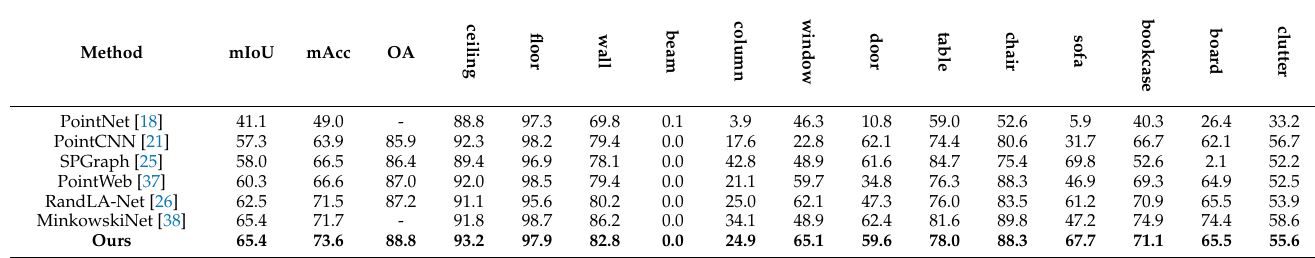
Table 1. Comparison of the semantic segmentation tested on the S3DIS area 5.